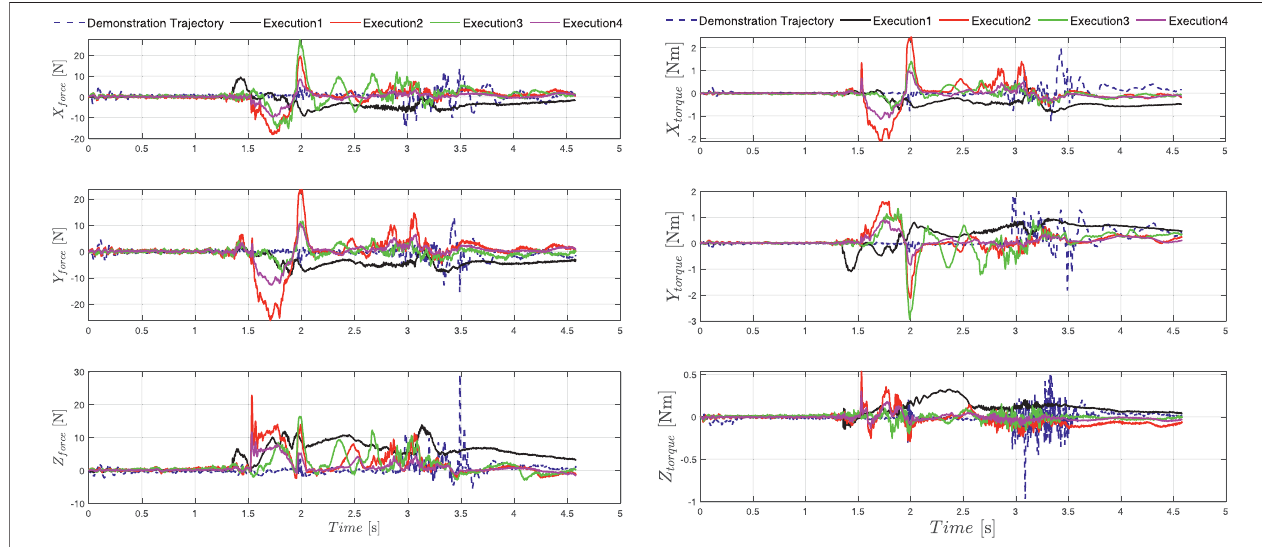
FIGURE 10 | The demonstrated force-torque pro fi le is represented with dashed blue line, solid lines represent forces and torques during the execution of the demonstrated assembly tasks at different locations of the timber studs in the workspace of the robot.